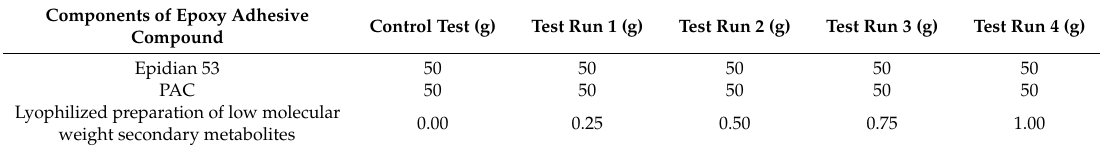
Table 3. Modified epoxy adhesive compounds